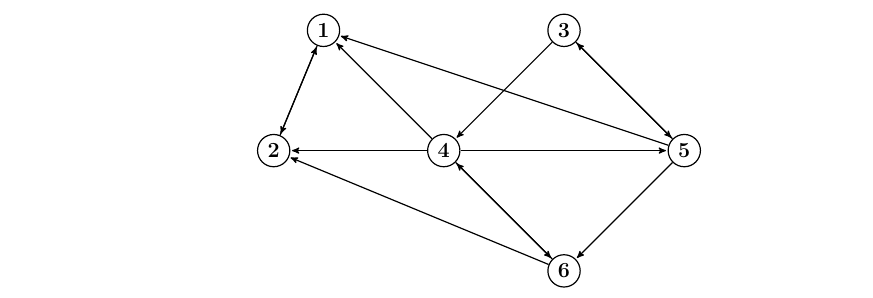
> 0 loops are not ii